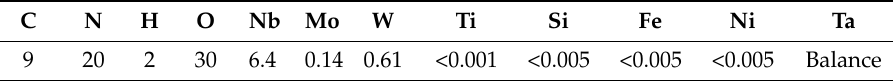
Table 1. The chemical composition of the original tantalum ingot (in wt.